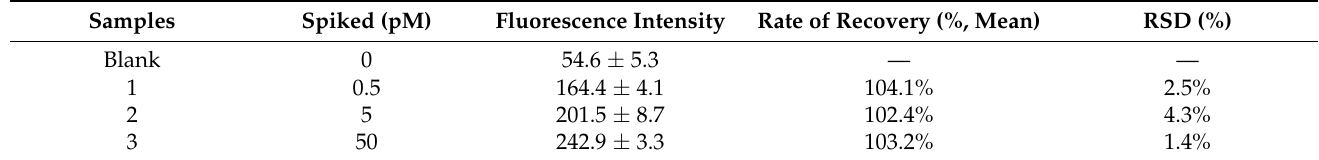
Table 3. The detection of recovery rate of three different concentrations of STX in mussel